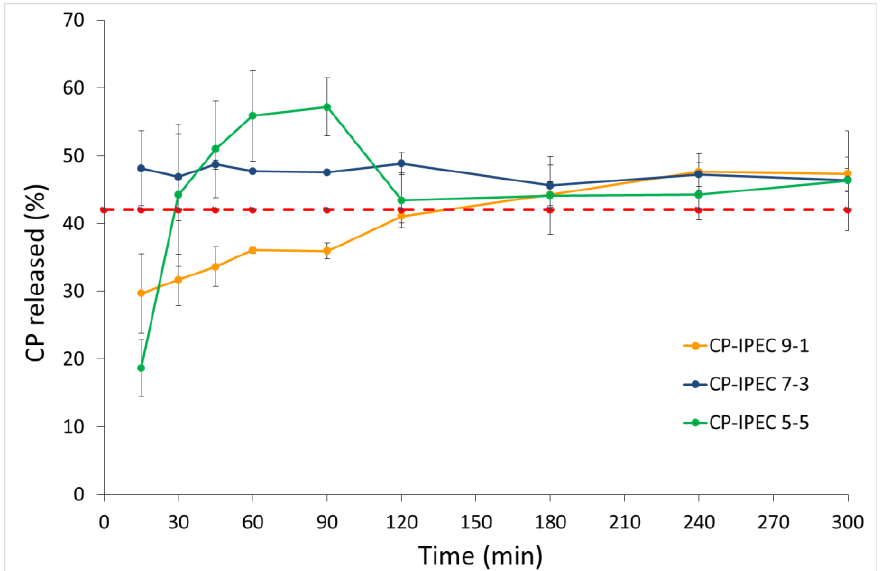
Figure 5. In vitro dissolution profile of CP from oral lyophilisates containing CP-IPEC w/w : 9:1 (90:10), 7:3 (70:30), and 5:5 (50:50) under oversaturation conditions. The dotted line corresponds to the CP solubility at the saturation.